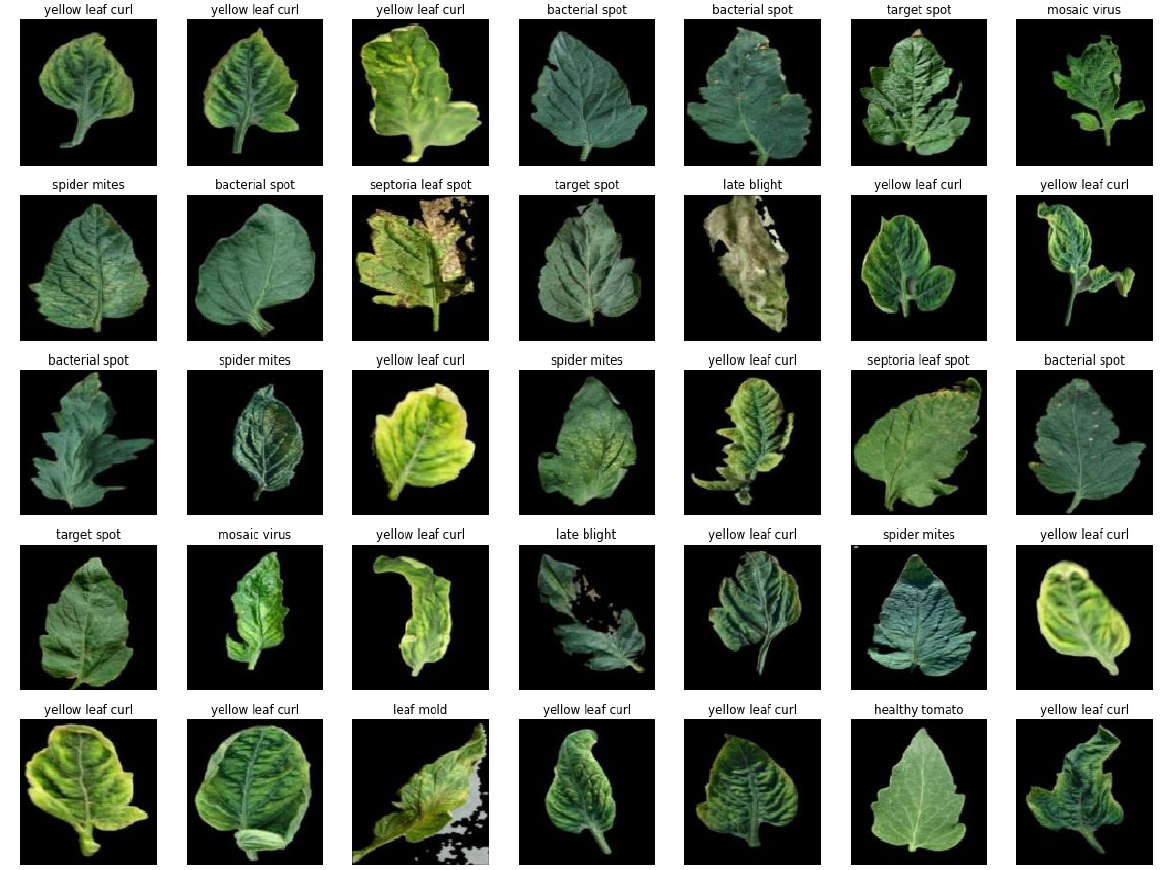
Figure 15. Samples from the tomato leaf dataset.